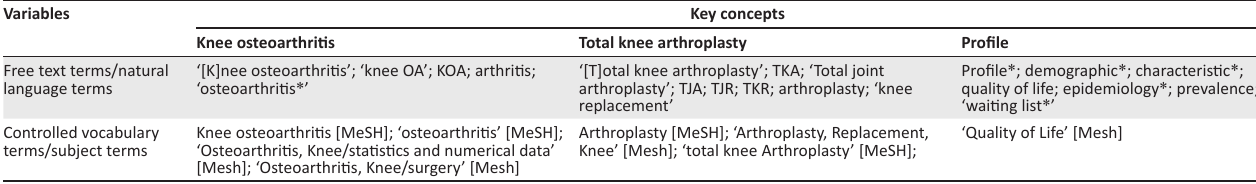
TABLE 1: Proposed key search